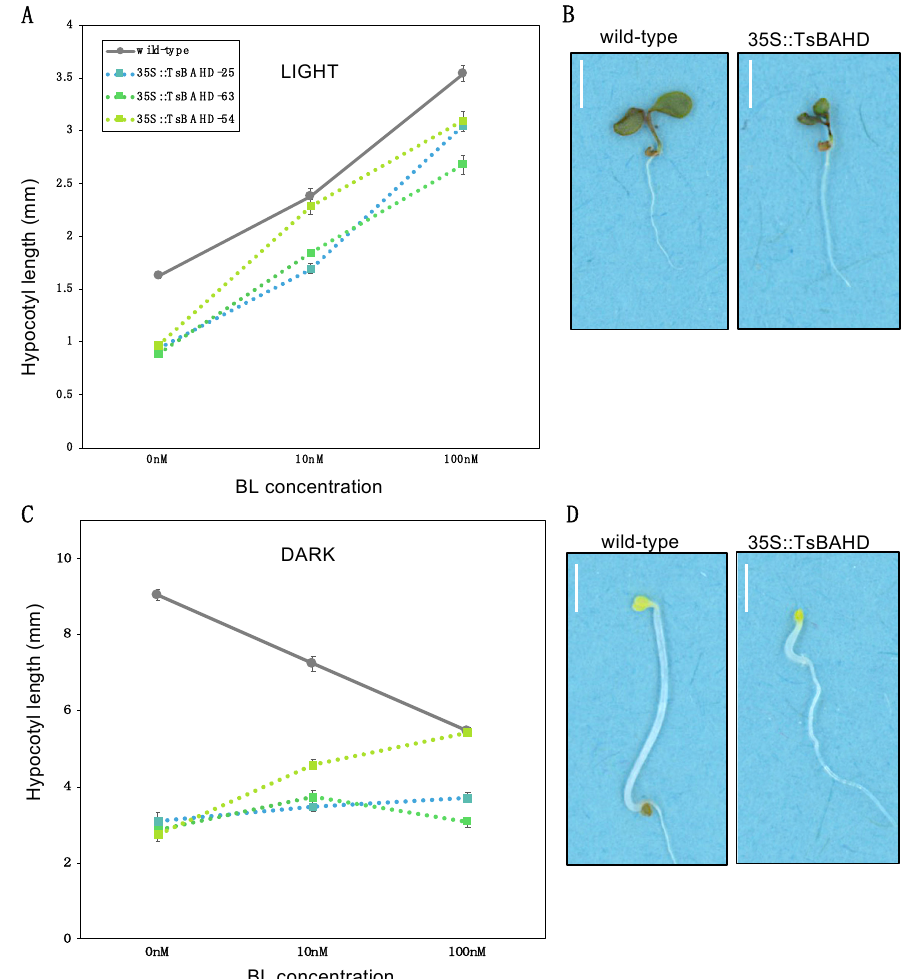
Figure 5. Hypocotyl response to different concentrations of brassinolide (BL) in light ( A , B ) and dark ( C , D ). Seedlings pictured are representatives of wild type and 35S::TsBAHD lines from plates with 0 nM BL. Hypocotyls of 4 day old seedlings were grown on plates at 25 °C in continuous light at an intensity of 80 μ E and in complete darkness. Plates contained half strength Linsmaier and Skoog modified basal medium, 0.6% Gellan, and 1.5% sucrose. BL concentrations were 0, 10, and 100 nM. Green dotted lines represent two replicates of three independent lines of 35S::TsBAHD and solid gray line represents the wild type. Errors bars represent standard error. Scale bars = 2 mm.